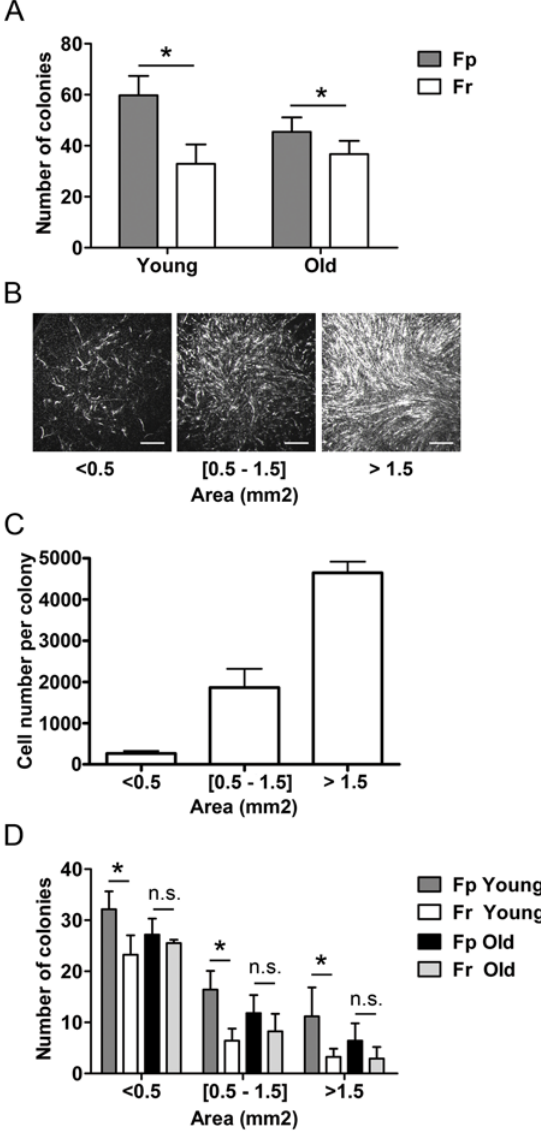
Figure 6. Evolution with age of Fp and Fr clonogenic capacity. The growth capacity of Fp and Fr samples from 4 young (19 yr, 21 yr, 23 yr, and 26 yr) and 4 old donors (57 yr, 60 yr, 63 yr, and 74 yr) was analyzed in term of colony-forming efficiency (CFE) and size of the colonies generated by these different fibroblast samples. (A) Compar- ison of the CFE of Fp and Fr from young and old donors. Data are expressed as number of colonies obtained from 100 plated fibroblasts (means 6 SEM, n=4, independent samples). Colonies were classified according to their individual area (mm 2 ). (B) Photographs of colonies of typical ‘small’, ‘intermediate’, and ‘large’ size. Scale bars=50 m m. (C) Correspondence between colony area (mm 2 ) and fibroblast number (means 6 SEM, n=10 colonies per size category). (D) Comparison of the sizes of colonies generated by Fp and Fr from young and old donors. The histogram shown corresponds to the number of colonies obtained from 100 plated fibroblasts (means 6 SEM, n=4, independent samples), (*p , 0.05; n.s.=not